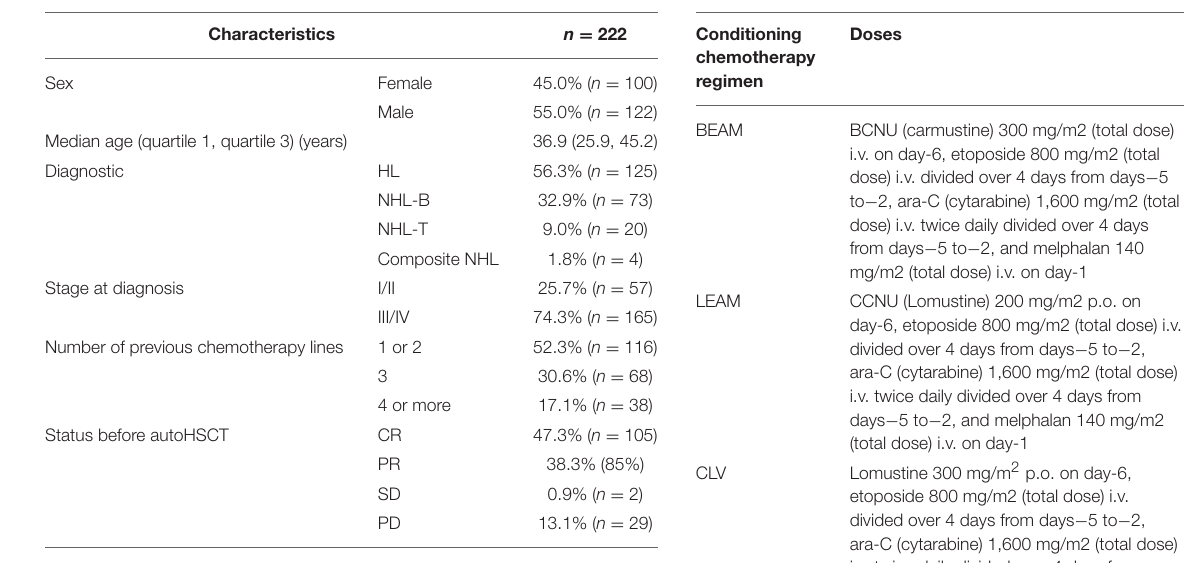
TABLE 2 | Detailed dosages for the conditioning